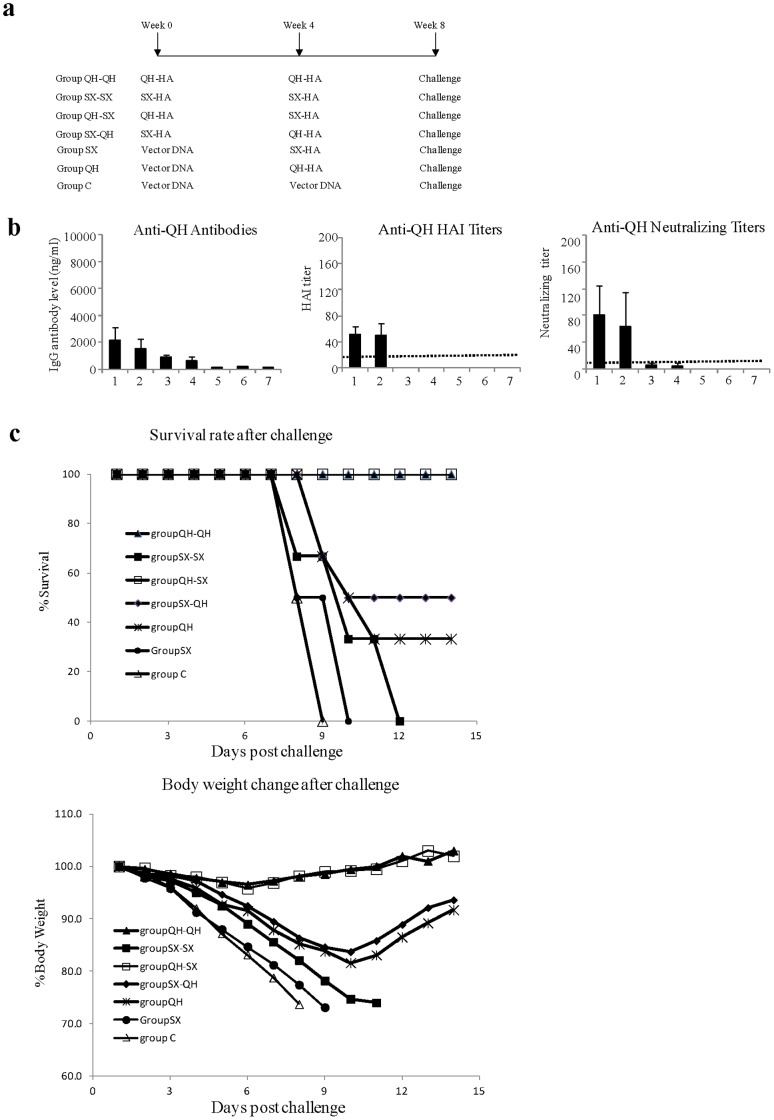
A heterologous boosting with SX HA DNA vaccine protected mice against lethal challenge by the QH H5N1 influenza virus.(a) Schematic diagram of the immunization and challenge studies. (b) At 2 weeks after the second immunization, blood samples were collected and analyzed for antibody responses against the QH virus by ELISA, HAI, and virus-neutralization assays. Data are presented as the mean ± standard deviation. Dashed lines indicate detection limit for HAI titer (1∶20) and neutralizing titer (1∶10). 1, Group QH-QH; 2, Group QH-SX; 3, Group SX-QH; 4, Group QH; 5, Group SX; 6, Group SX-SX; 7, Group C. (c) Mouse survival rate and body weight change after lethal influenza virus challenge. At 4 weeks after the second immunization, mice were challenged by intranasal instillation with 100 MLD50 of the QH H5N1 influenza virus and then monitored daily for weight loss and disease progression. Mice that were found to display severe signs of illness or loss more than 25% body weight were sacrificed in accordance with IACUC guidelines.